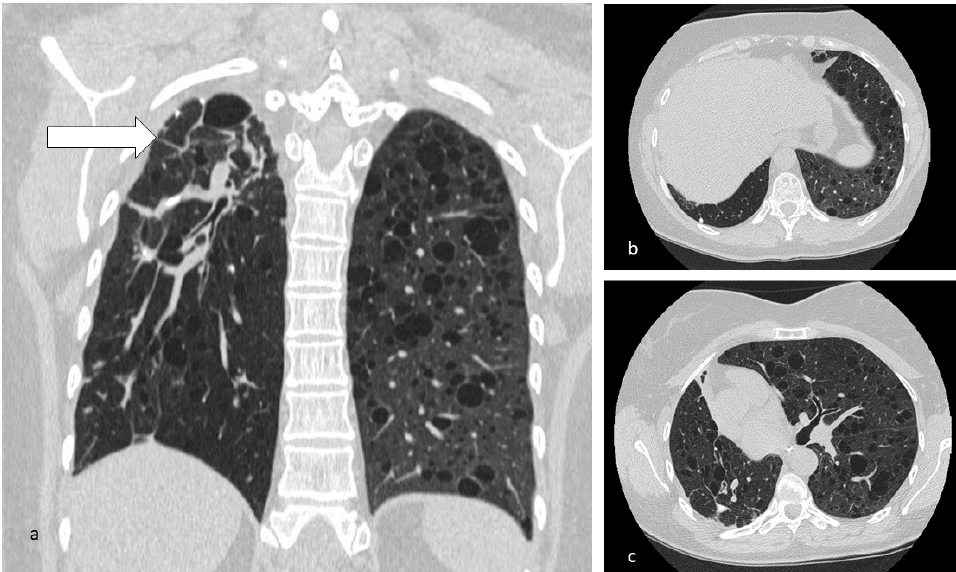
Figure 7. Cysts in LAM typically distributed through all the lungs ( b , c ). In this case, the irregularly shaped cystic/fibrotic formation at the right superior lobe is to refer to a previous tubercular infection ( a